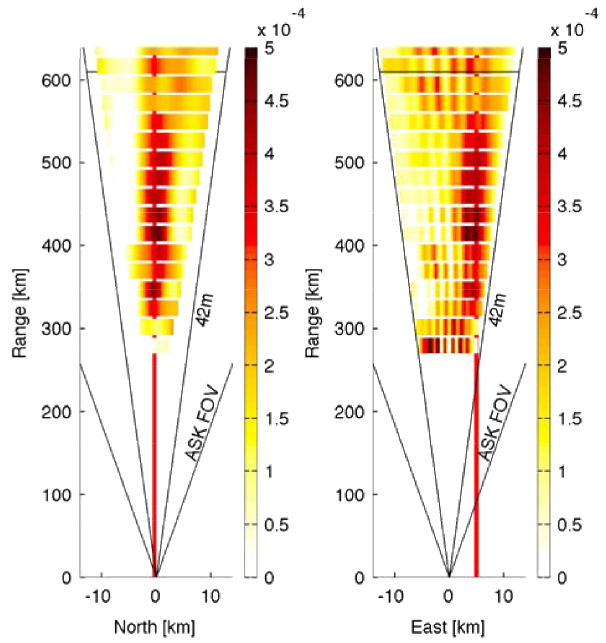
Figure 7. Beam cross-sections of the backscatter distribution de- rived for the down-shifted ion line shoulder. The red vertical line in- dicates the magnetic field close to the region from which enhanced backscatter is thought to arise and corresponds to the field line dis- played in Fig.